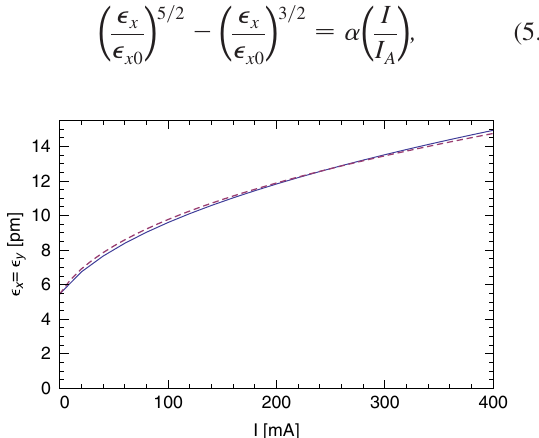
FIG. 12. Steady-state emittances as a function of bunch current in PEP-X with round beams ( k ¼ 1 ).